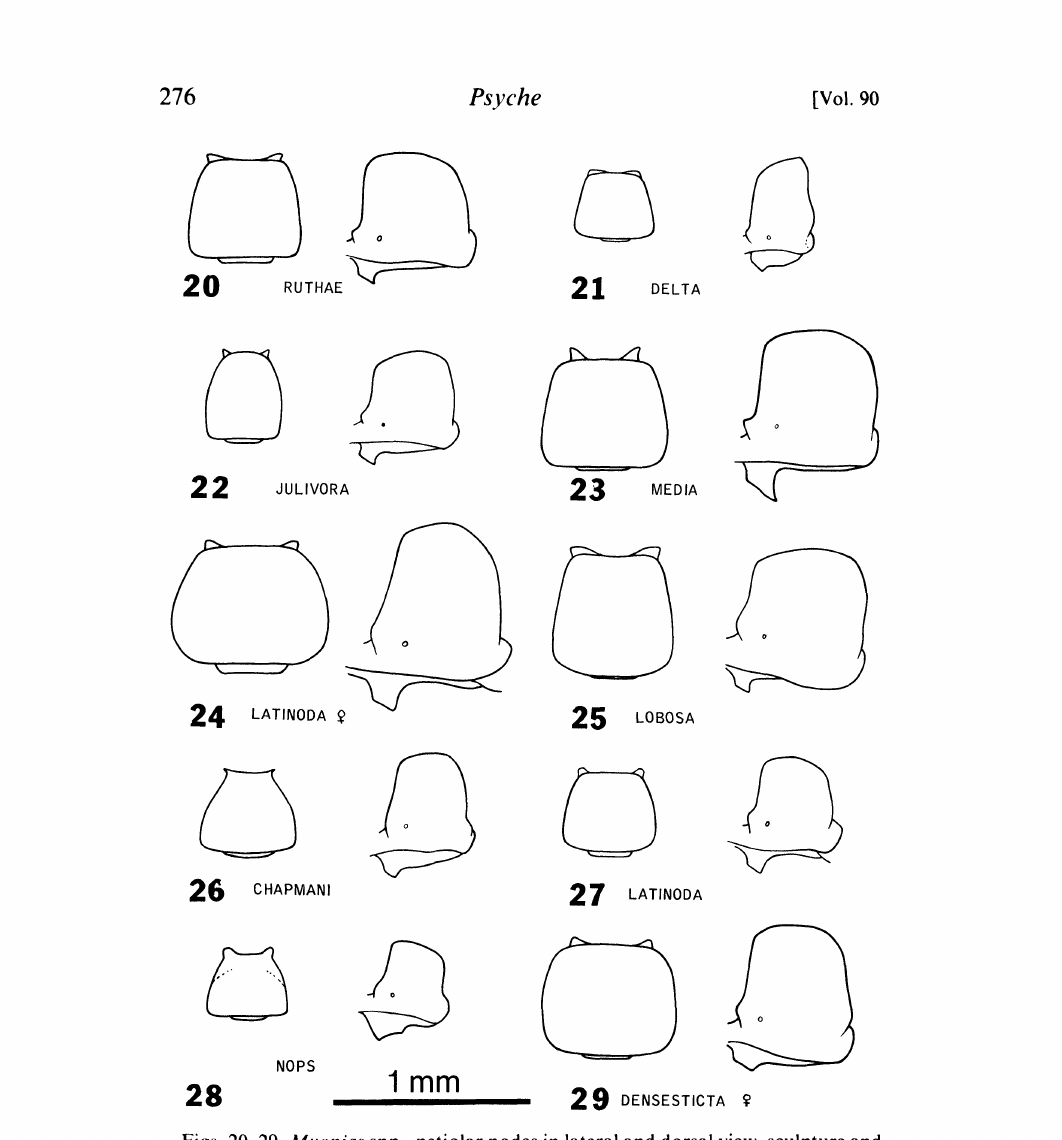
Figs. 20-29, Myopias spp., petiolar nodes in lateral and dorsal view, sculpture and pilosity omitted, all to same scale. Fig. 20, M. ruthae holotype worker. Fig. 21, M. delta, paratype worker. Fig. 22, M. julivora, paratype worker from Papua New Guinea. Fig. 23, M. media, holotype worker. Fig. 24, M. latinoda queen from Maffin Bay, Irian Jaya. Fig. 25, M. Iobosa, paratype worker. Fig. 26, M. chapmani, para- type worker. Fig. 27, M. latinoda worker from Maffin Bay, Irian Jaya. Fig. 28, M. hops, holotype worker. Fig. 29, M. densesticta paratype queen from Kuranda,